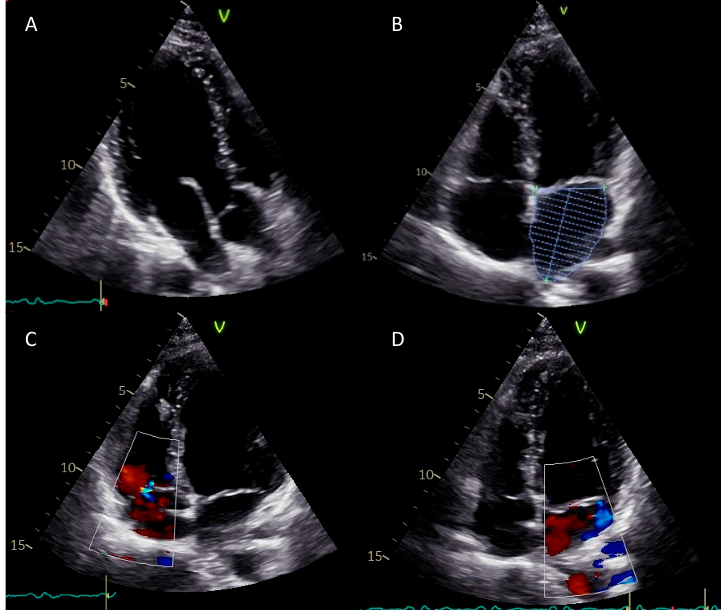
Figure 4. Complete baseline two-dimensional transthoracic echocardiography: three-chamber view ( A ); four-chamber view ( B ) with volumetric assessment of the left atrium (32 mL); color-Doppler four-chamber view ( C , D ). See text above for further details.